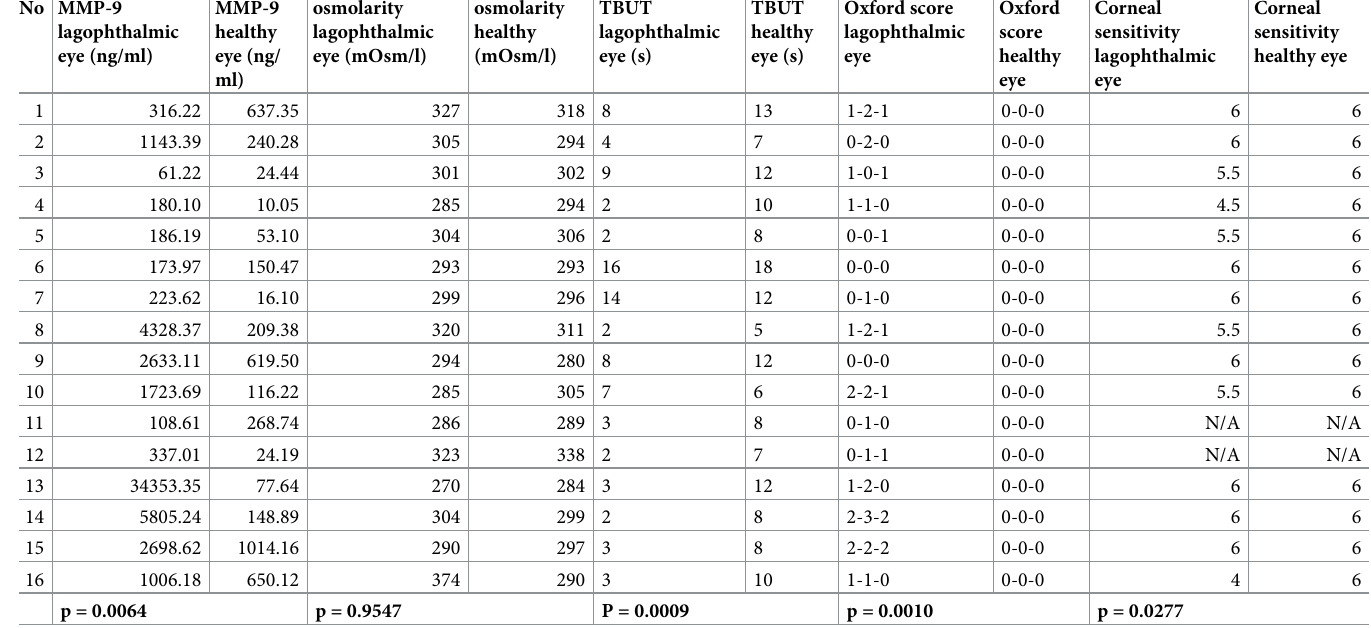
Table 2. Detailed test